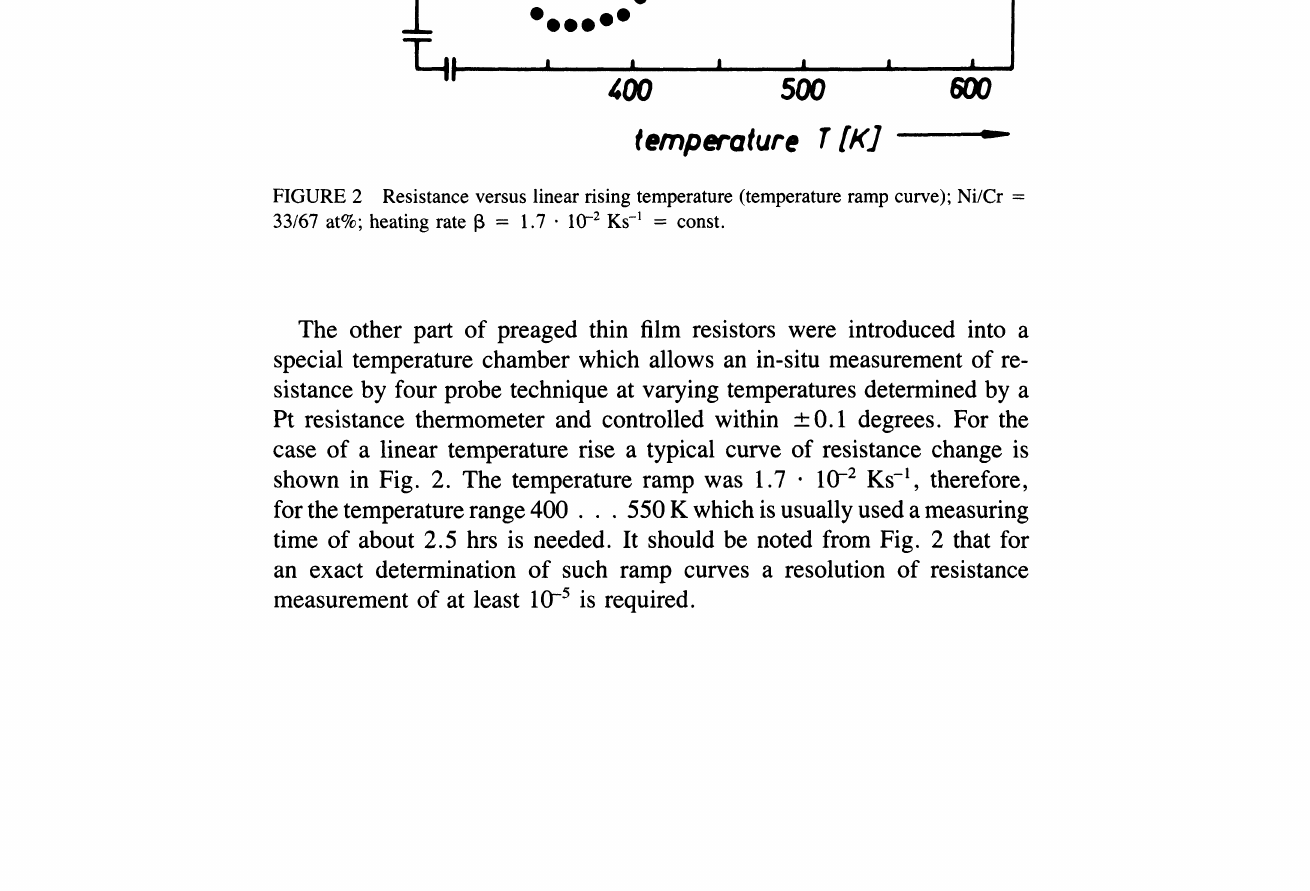
- FIGURE 2 Resistance versus linear rising temperature (temperature ramp curve); Ni/Cr 33/67 at%; heating rate 13 1.7 10 -2 Ks